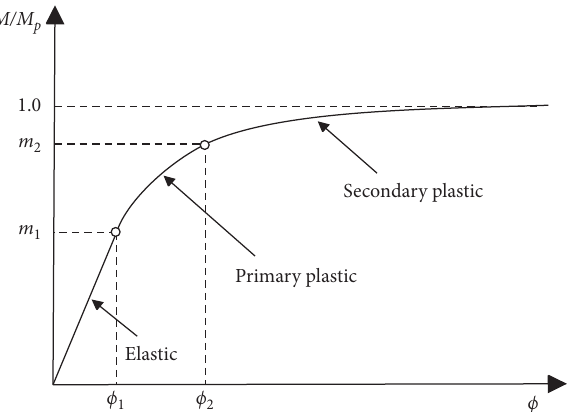
Curve 1: response for nonsoftening soil Curve 2: response for softening soil Curve 3: limit load for nonsoftening soil Curve 4: limit load for soil with residual